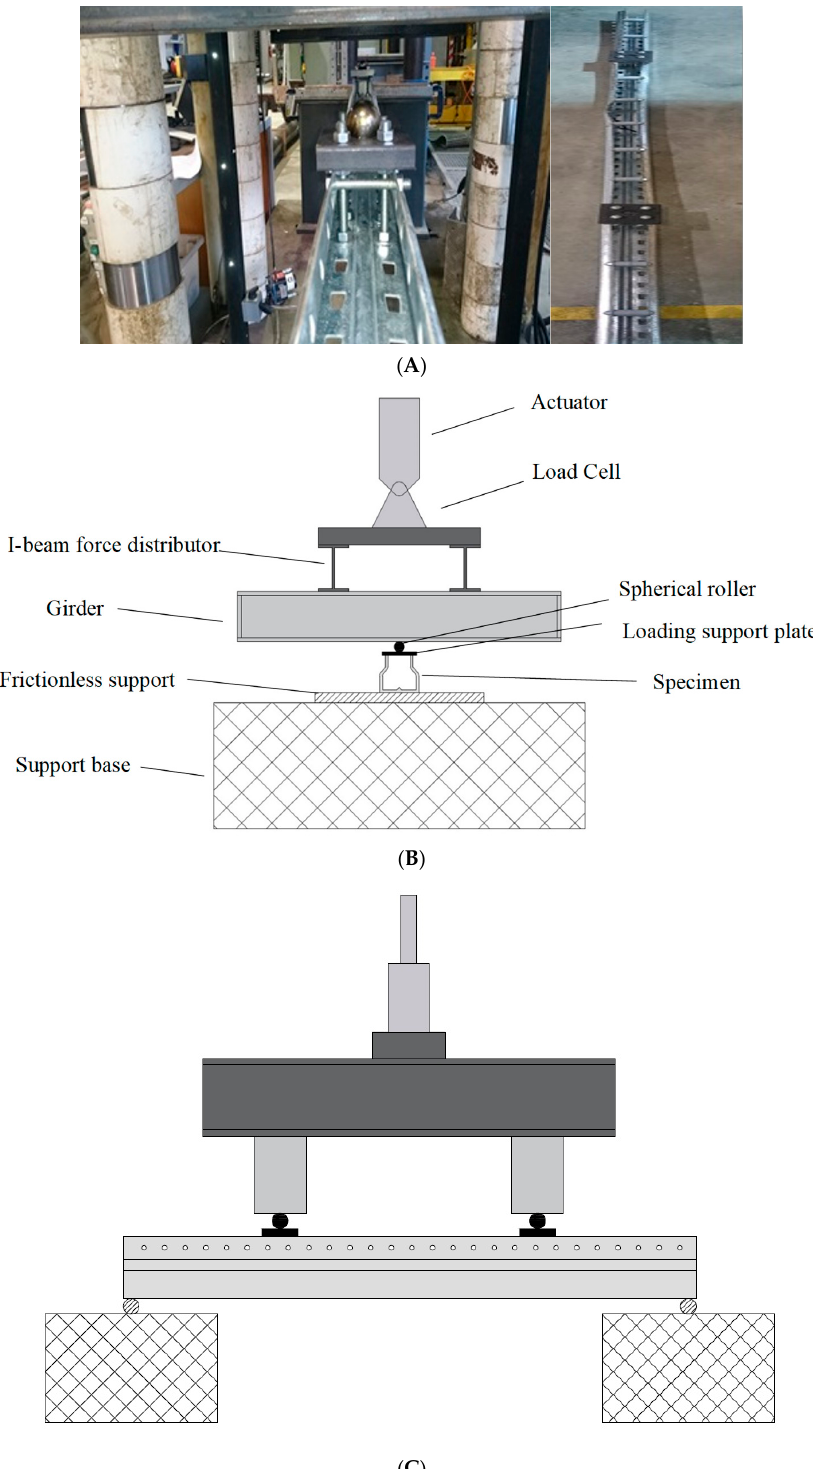
Figure 6. Minor axis test set-up details: ( A ) Test specimen; ( B ) schematic front view; ( C ) schematic side view.